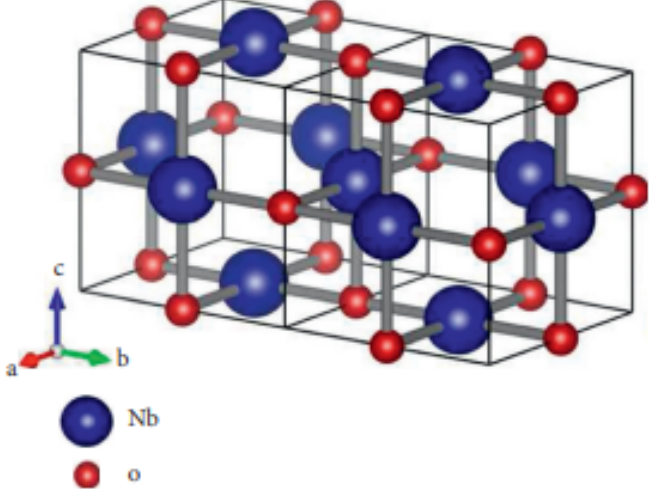
Figure 1. Niobium dioxide 3D structure.